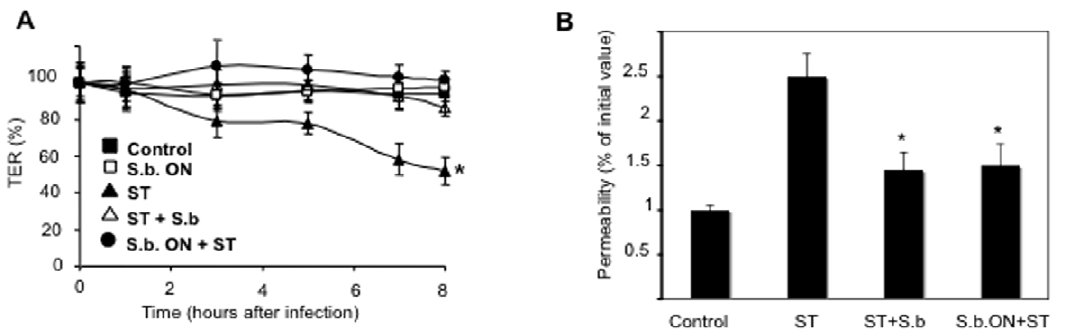
Figure 4. S.boulardii preserves barrier function of S. Typhimurium-infected T84 cells. (A) Transepithelial electrical resistance (TER) were measured at different time in: (Control) control T84 monolayers, (S.b. ON) monolayers incubated with S. boulardii alone (overnight), (ST) monolayers infected with ST alone, (ST + S.b.) monolayers infected with ST in the presence of S. boulardii added at the same time, or monolayers incubated overnight with S. boulardii prior the infection (S.b. ON + ST). The TER values are displayed as percentages of initial values. (n=5). An asterisk denotes significantly different versus control cells (P , 0.05). (B) Permeability of T84 monolayers to FITC-dextran was determined in monolayers exposed to ST alone or to ST and S. boulardii . Graph represents percentages of variation of permeability as compared to initial value (t=30 min) of each monolayers. (n=2). An asterisk denotes significantly different versus ST infected cells (P , 0.05). The data are expressed as means 6 SEMs.